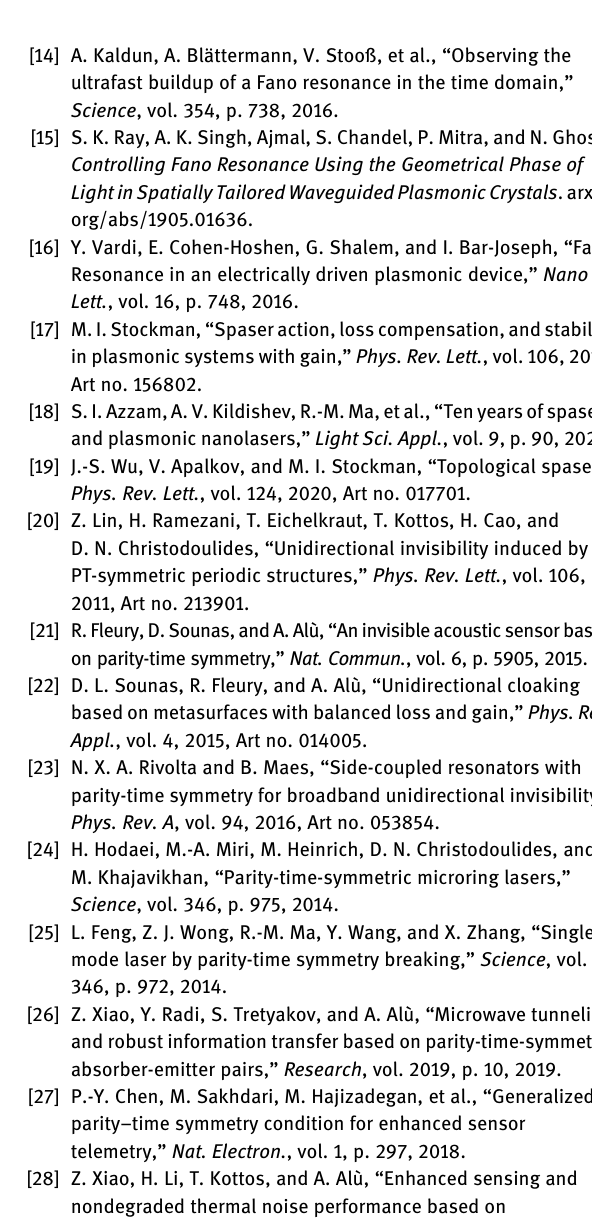
Figure 11: Power reflection and transmission spectra for ω 0 = 1 , γ 0 = 0 . 05 , γ (a) Double Lorentzian resonances with κ < κ EP . (b) Single Lorentzian resonance κ = κ EP . (c) Single Lorentzian resonance with κ > κ EP